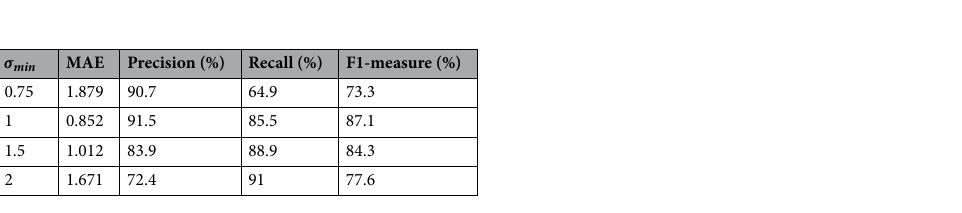
Table 3. Influence of the σ min in counting and detection of M. flexuosa palms-trees ( σ max = 4 and stages T = 4 were